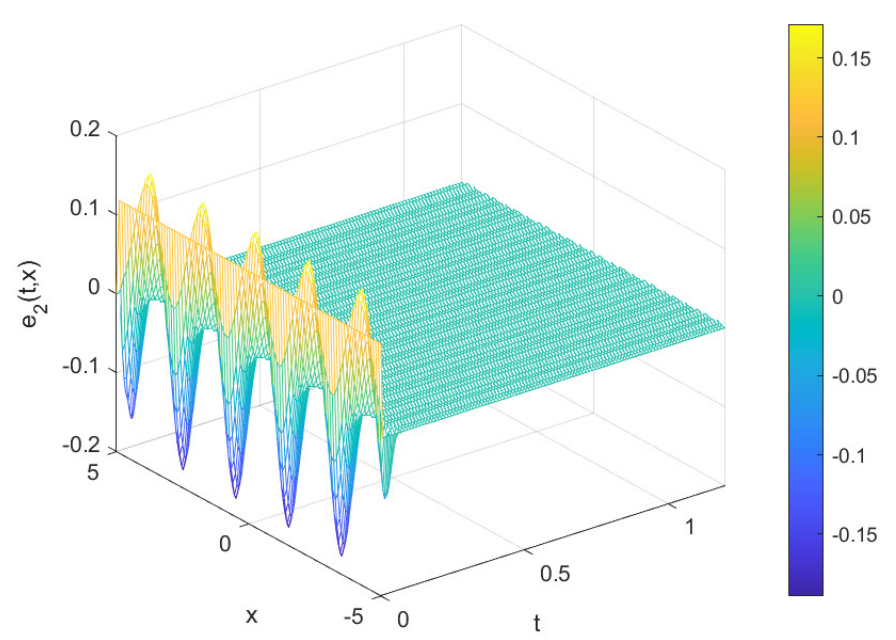
Figure 5. Time evaluation of synchronization error of e 2 ( t , x )